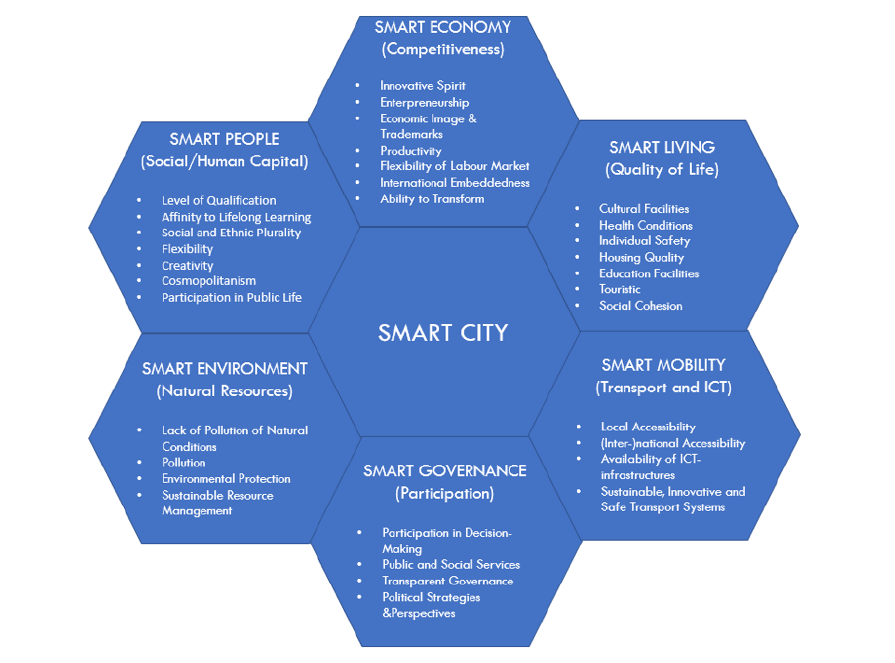
Figure 1. Smart city pillars and